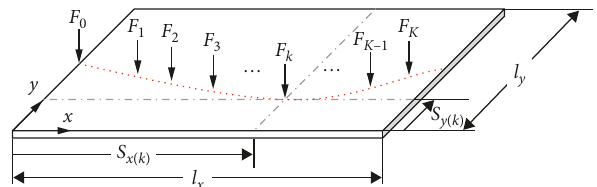
Figure 2: Frequency-domain representation of a moving point force P as a series of stationary point forces F k ( k